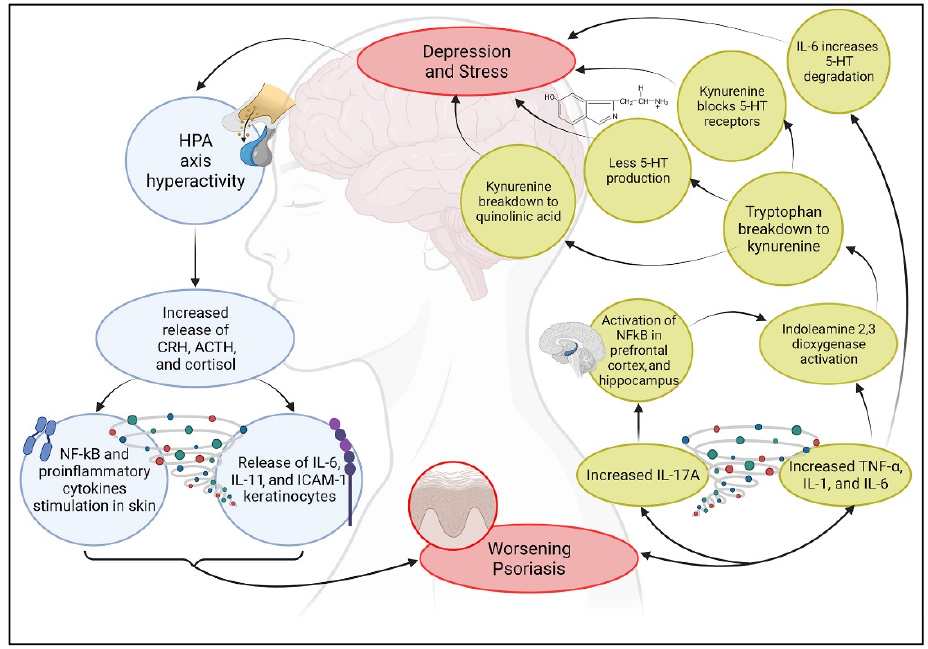
Figure 4. Interactive relationship between psoriasis, depression, and stress. This graphic scheme summarizes the biological cyclic mechanism discussed in this review. Created with BioRender.com (accessed on 14 March 2022).